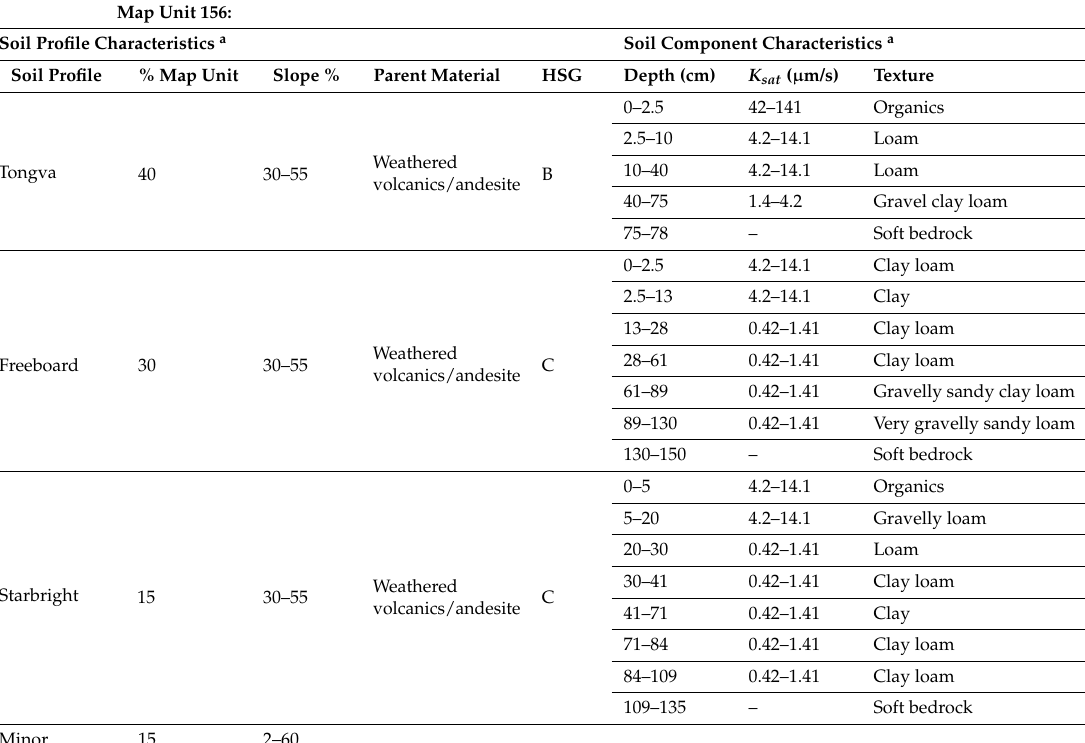
Table 4. Soil Complex Schematic Example.